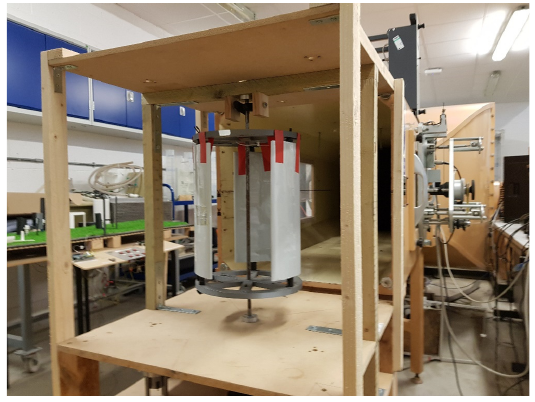
Figure 6. VAWT experiment setup.